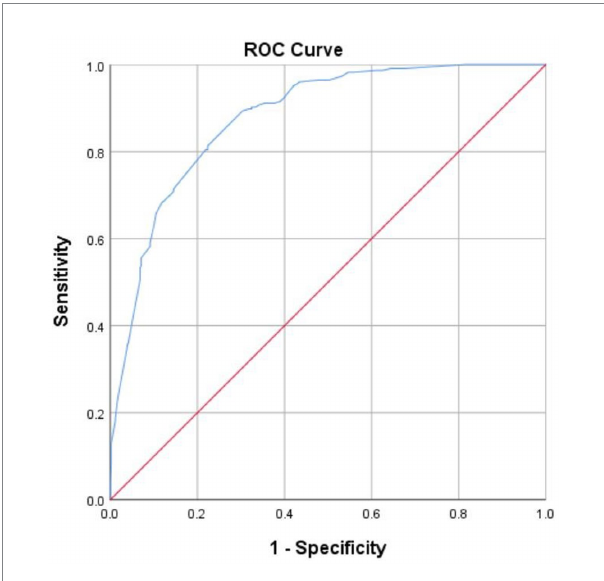
FIGURE 1 Receiver operating characteristic curve (ROC) of a predictive model of depression in recurrent pregnancy loss (RPL)